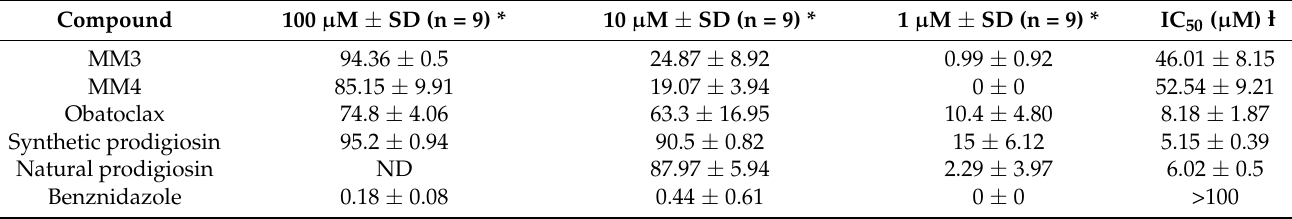
Table 5. Cytotoxicity values of tambjamines, Obatoclax, synthetic and natural prodigiosins, and benznidazole at the concentrations of 100, 10, and 1 µ M in human hepatocarcinoma cells (Hep G2). Compound